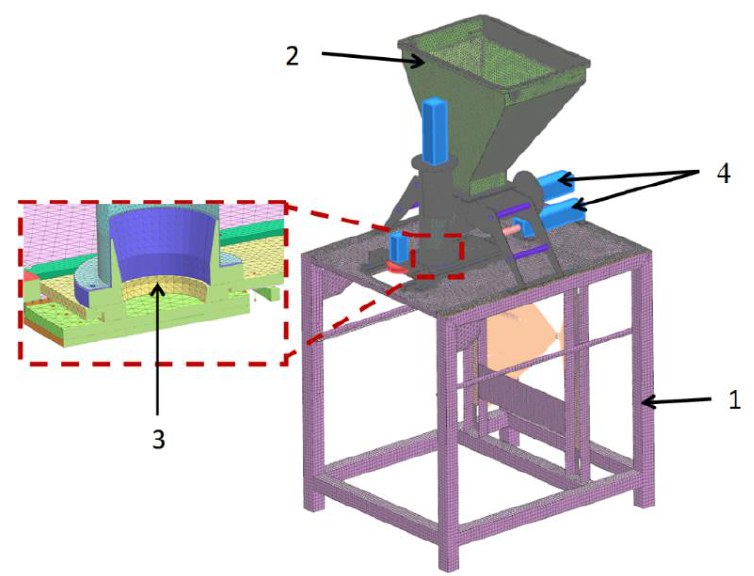
Figure 3. Calculation model of molding module: 1. support frame; 2. molding center with processing tank; 3. die assembly; 4. set of actuators.